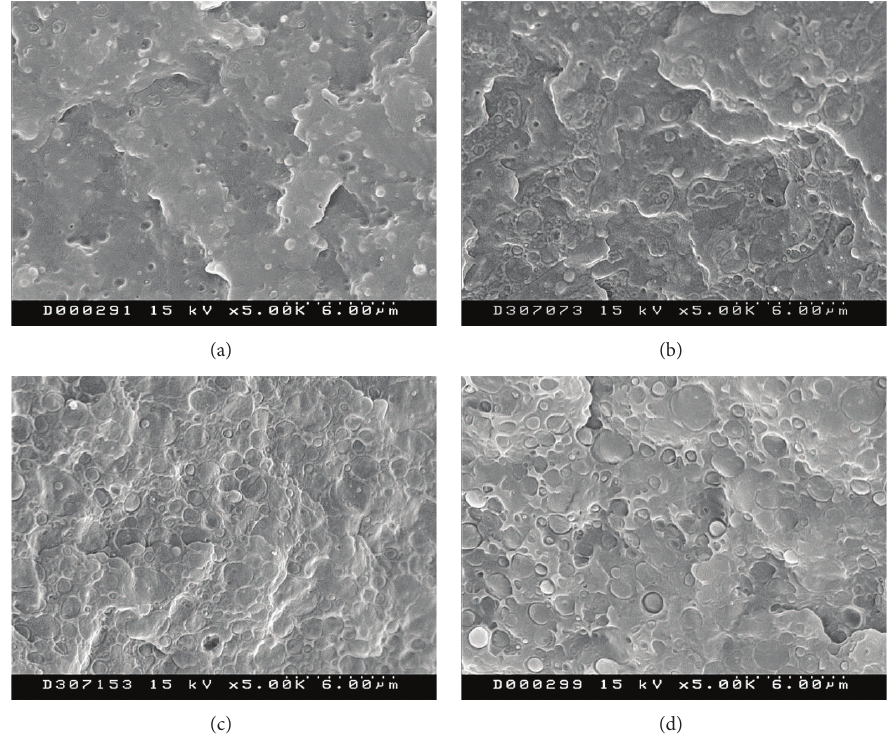
Figure 2: SEM micrographs of (a) 75/25, (b) 60/40, (c) 40/60, and (d) 25/75 gPP/PA12 blends.